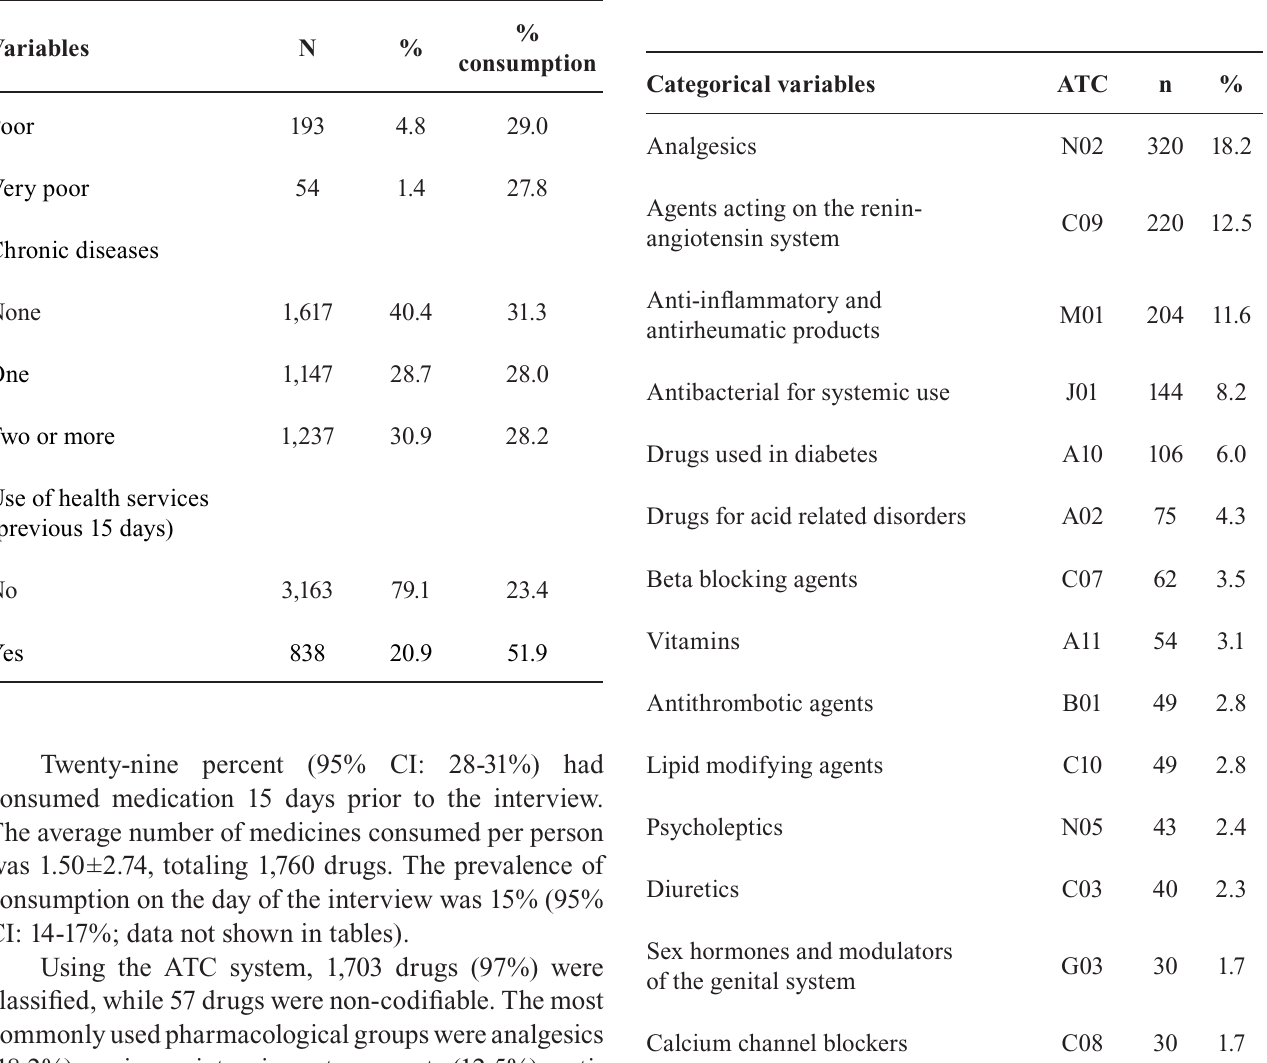
TABLE II - Medicines used in the 15 days prior to data collection according to pharmacological classes (third